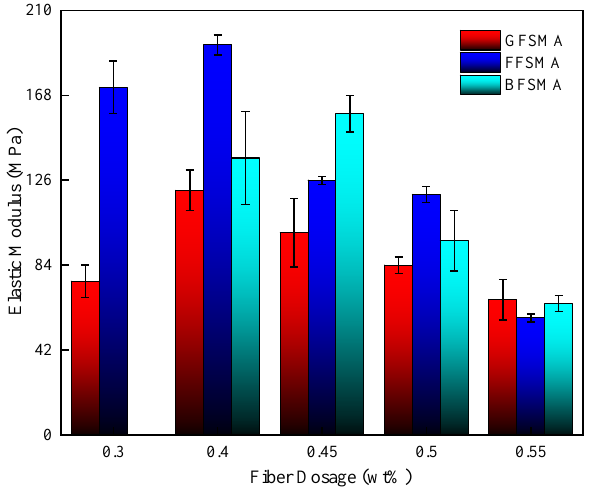
Figure 9. Elastic modulus of mixtures.